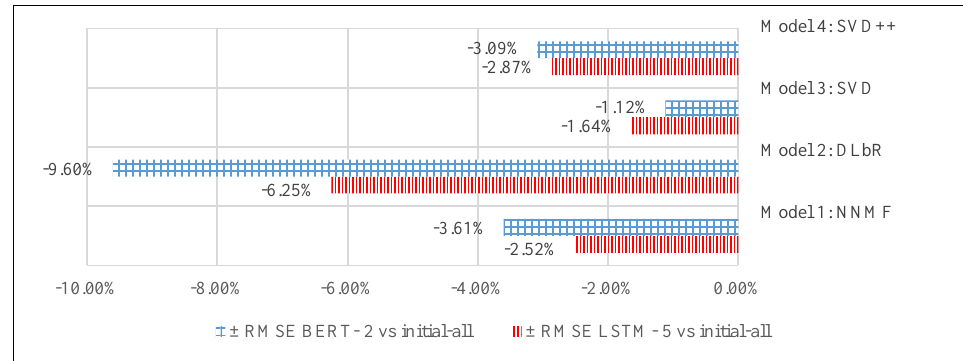
Figure 9. Comparison of the variations produced when using LSTM-5 or BERT-2 against the dataset 𝐷𝐴𝑇𝐴 𝑖𝑛𝑖𝑡.−𝑎𝑙𝑙 , of the four models in the RMSE indicator.